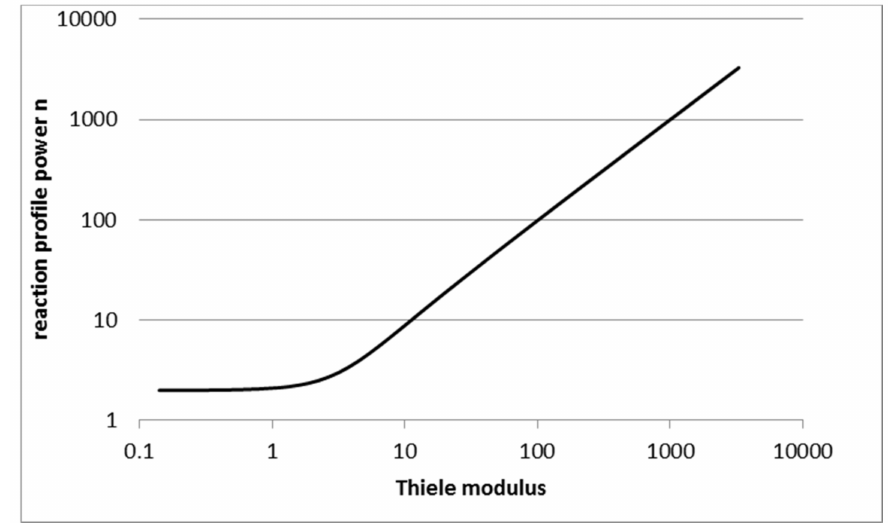
Figure 2. Reaction rate profile power as a function of Thiele modulus for spherical geometry.